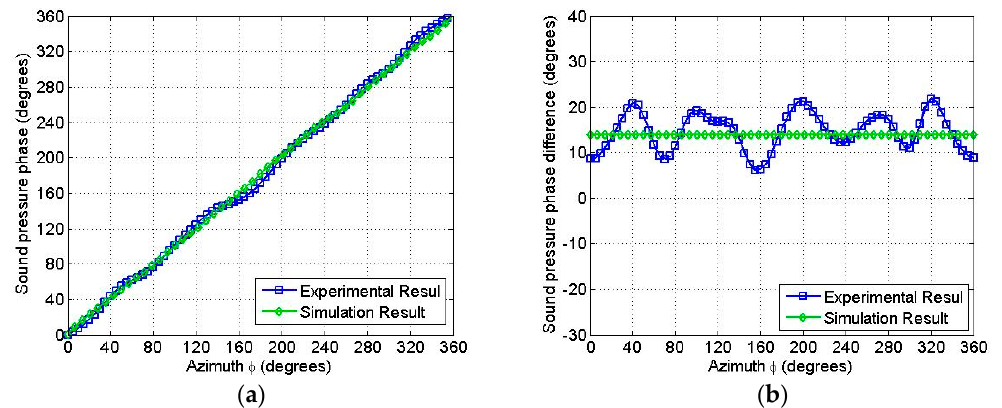
Figure 15. ( a ) The received signal sound pressure phase obtained by one hydrophone measurement, where the transducer rotated 360 degrees at 10.8 kHz; ( b ) The received sound pressure phase difference from two hydrophones by rotating the transducer for 360 degrees at 10.8 kHz.